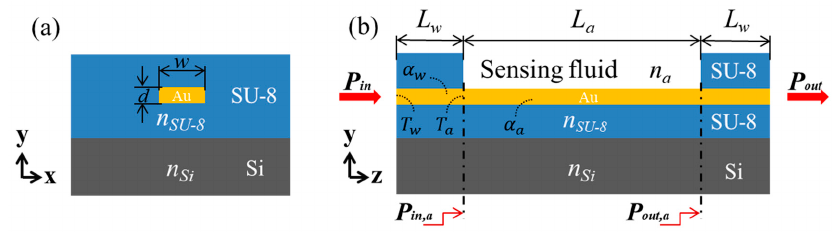
Figure 1. Schematic diagram of the straight long-range surface plasmon polariton (LRSPP) waveguide refractive index (RI) sensor: ( a ) Constructed by embedding the Au stripe of width w and thickness d in the polymer SU-8, and ( b ) with a microfluidic channel etched over the Au stripe to define the sensing region.